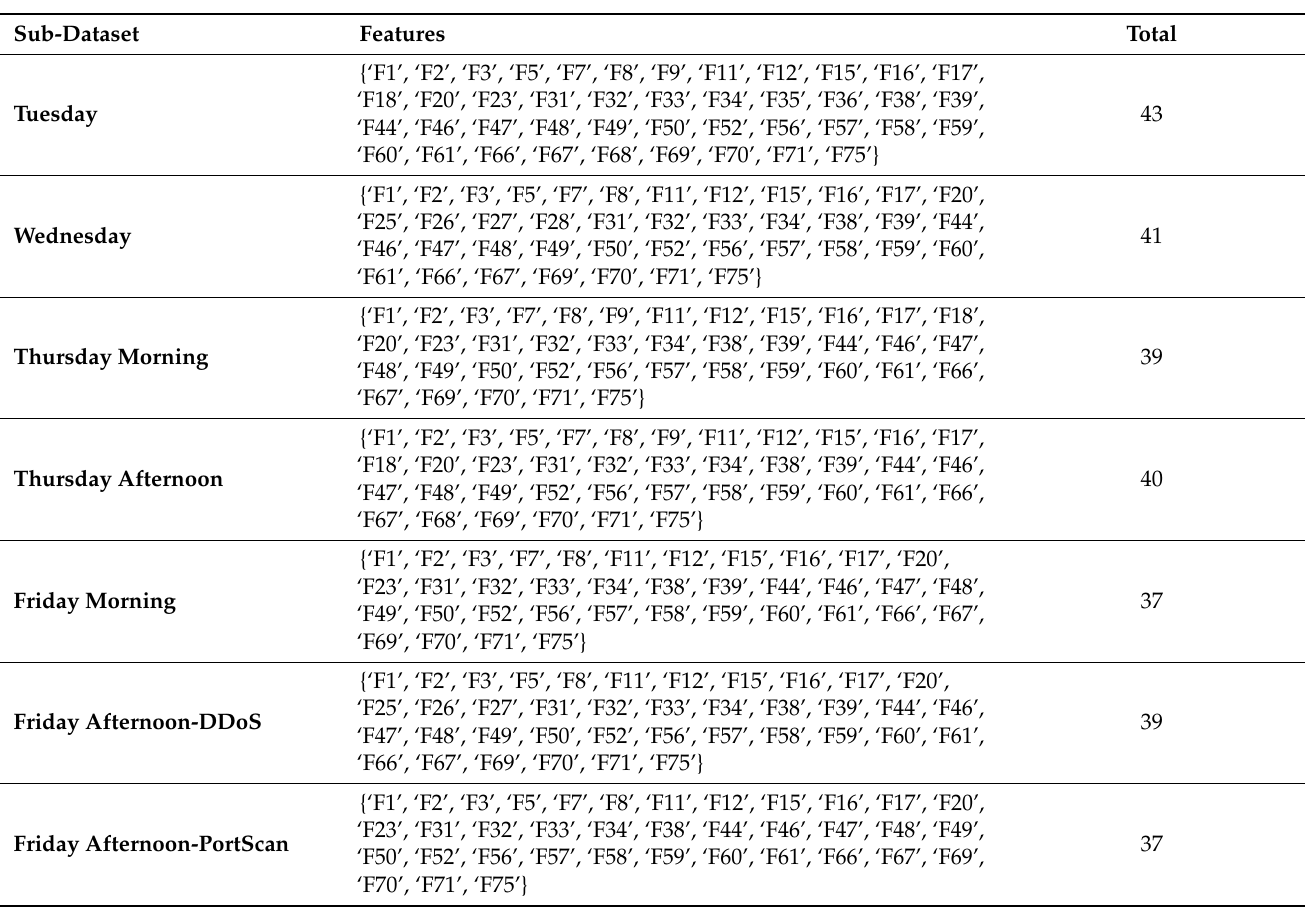
Table 3. Selected